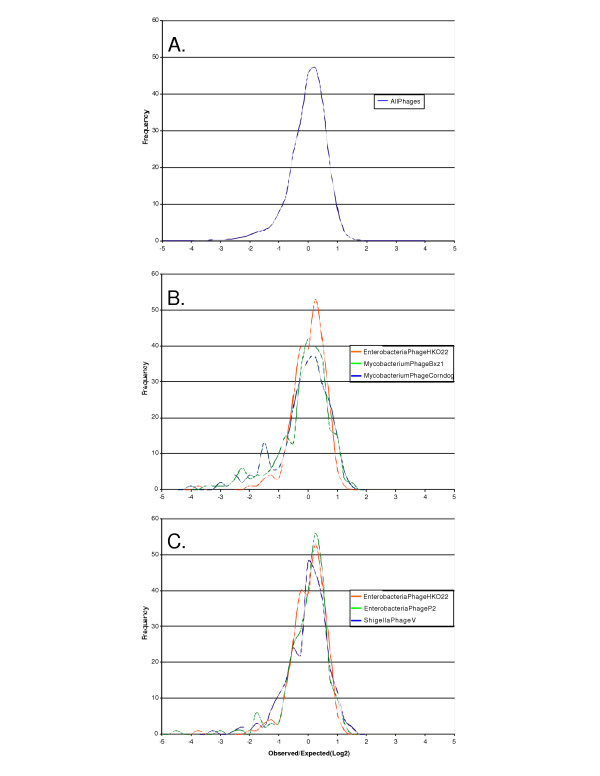
Frequency distribution of DNA tetranucleotide usage profiles of selected bacteriophages. The observed/expected TUD was determined for the 256 tetranucleotide combinations for each genome, as described in Materials and Methods. The resulting values were sorted within 0.25 intervals and the ordinate represents the number of tetranucleotide combinations within each interval. Panel A: Blue – All bacteriophages studied. Panel B: Red – Enterobacteria phage HK022 (Siphoviridae), Green – Enterobacteria phage P2 (Myoviridae), Blue – Shigella phage V (Podoviridae). Panel C: Red – Enterobacteria phage HK022, Green – Mycobacterium phage Bxz1 (Myoviridae), Blue – Mycobacterium phage Corndog (Siphoviridae).